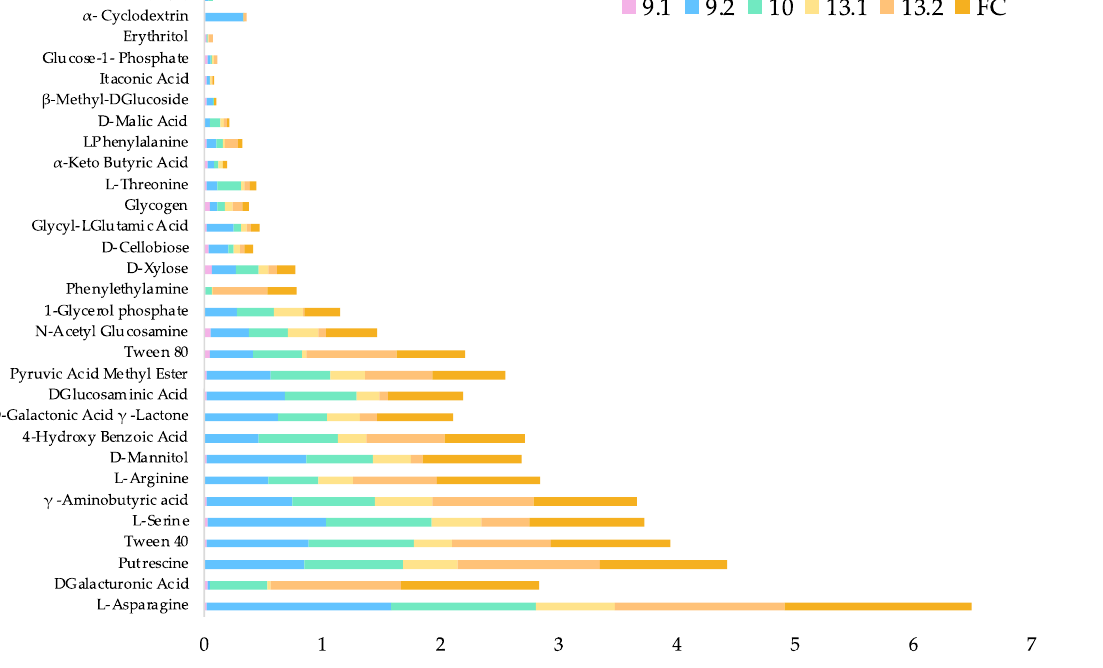
Figure 5. Comparison of relative carbon source utilization between the individual strains and the full consortium over 24-h using Biolog EcoPlates ® . Thirty-one carbon sources, in triplicate, were evaluated kinetically via a colorimetric assay over a 24-h period at room temperature (25 ± 2 °C). Triplicate values were averaged to determine relative absorbance compared to the control samples (water).